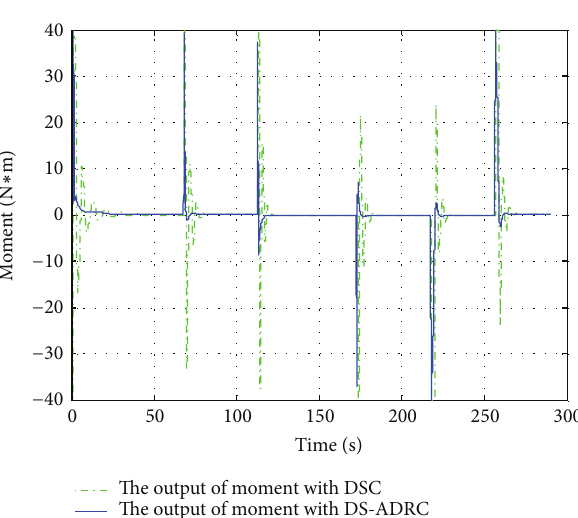
Figure 4: The responses of path following.